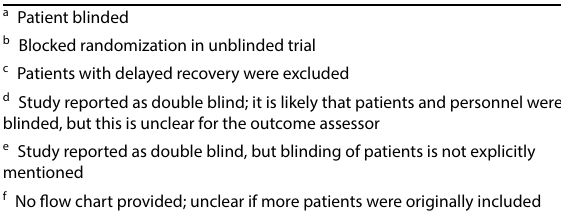
Table 2 Risk of bias assessment of included